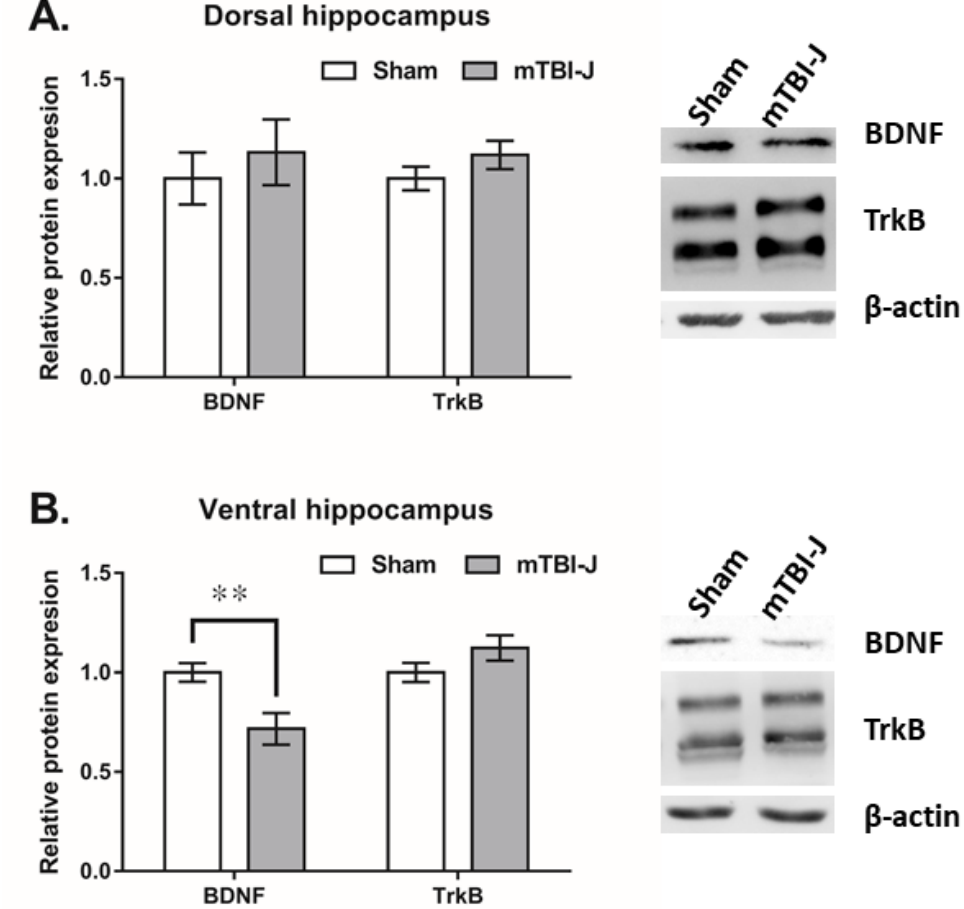
Figure 4. The hippocampal expression of BDNF and TrkB of the mTBI-J treated animals. ( A ) No significant difference was found between the BDNF and TrkB in the dorsal hippocampus of mTBI-J group and sham group ( B ) The expression of BDNF but not TrkB was decreased in the ventral hippocampus of the mTBI-J treated animals. Values are shown as mean ± SEM, ** = p < 0.01 compared with the sham control